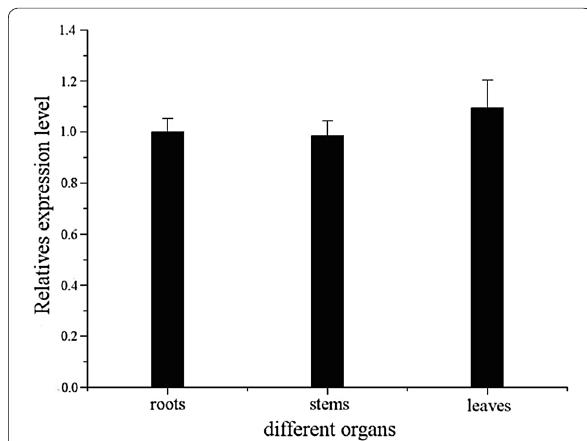
Fig. 4 The relative expression levels of EhAACT gene in the roots, stems and leaves of Euphorbia helioscopia . There was similar expres- sion level among roots, leaves and stems of EhAACT and no signifi- cant difference ( P < 0.05) among them